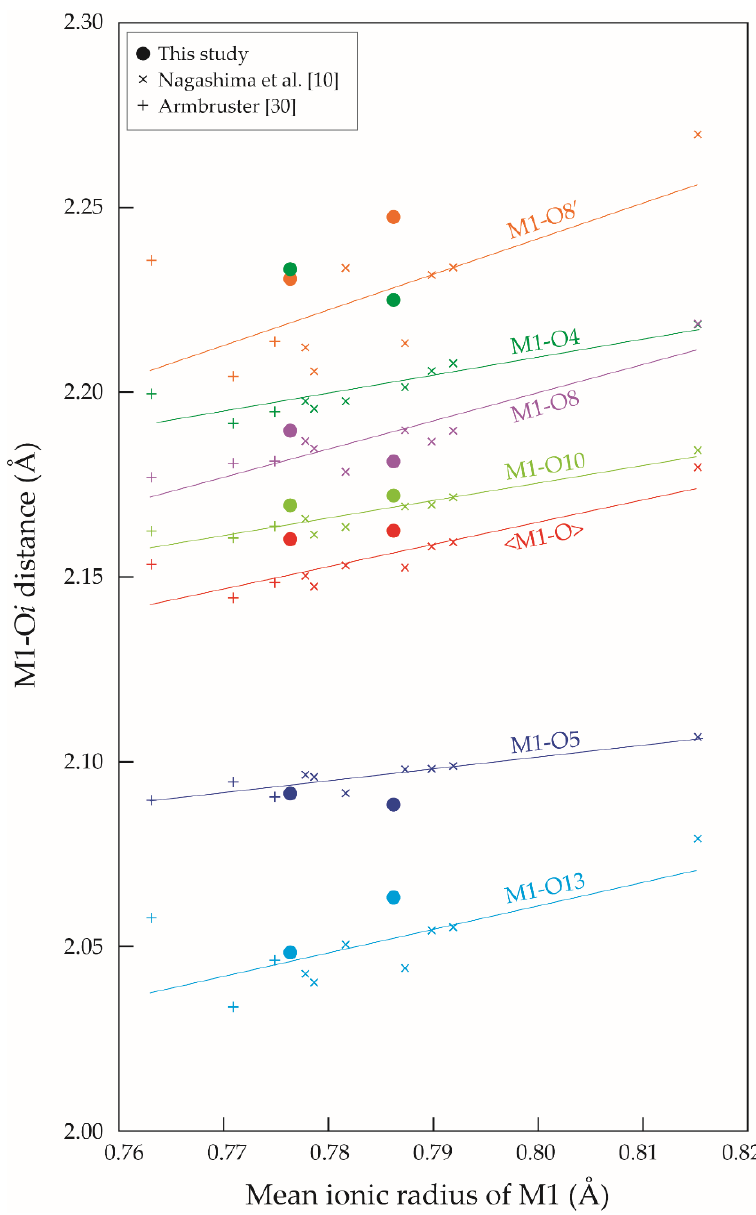
Figure 4. Variation of M1–O i distance (Å) as a function of mean ionic radii of M1 (Å). For the Heftetjern specimen, errors (1 σ ) are smaller than the symbols size. Errors (1 σ ) of Baveno specimen are almost same as size of symbols [10,30].